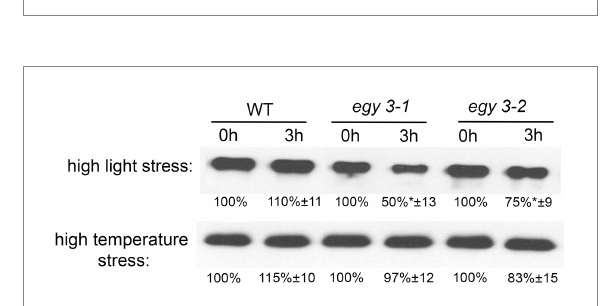
FIGURE 8 Immunoblot quantification of CSD2 protein in wild-type (WT) and egy3-1 and egy3-2 mutant plants under high light and high- temperature conditions. Plants were exposed to 1,000 μ mol m − 2 s − 1 (high light) or 40 ° C (high temperature) for 0 and 3 h. Total protein (5 μ g) was immunologically analyzed using an anti-CSD2 antibody. GelixOne software was used to quantify the CSD2 content. “±” indicates the SD determined in the analysis of samples obtained from three biological replicates, each of which was obtained by isolation of total protein from a minimum of 20